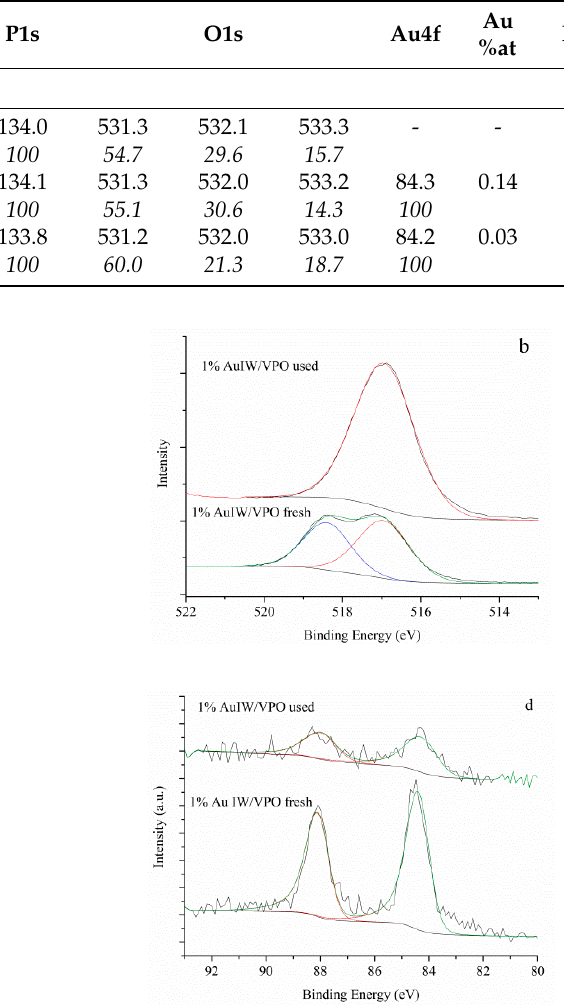
Table 2. XPS of 1% Au IW /VPO fresh and used catalysts.